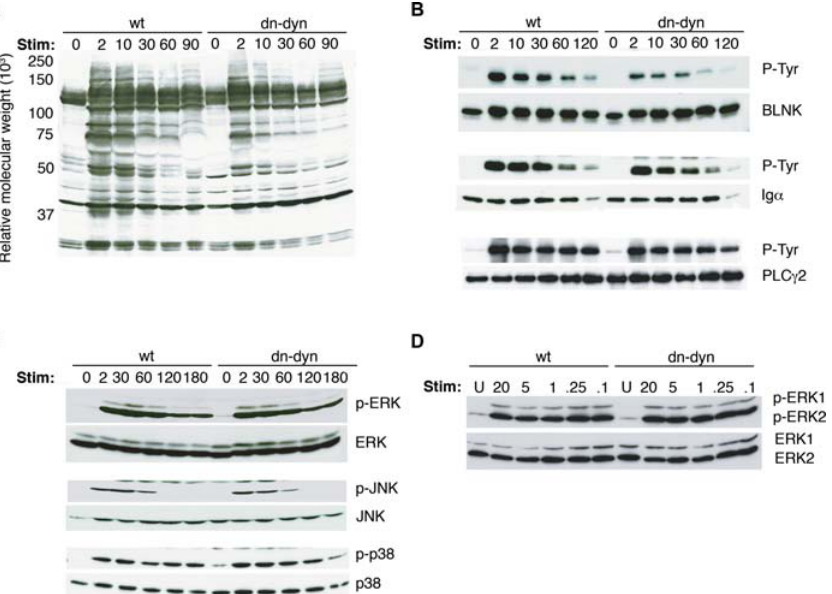
Figure 5. Inhibiting BCR Internalization Has Minimal Effect on Signaling In (A–C), A20IIA1.6 wild-type- or dn-dynamin-expressing cells were stimulated with anti-IgG for the indicated times (min). (A) Total cell lysates were immunoblotted with 4G10. (B) BLNK, Ig a , or PLC c 2 immunoprecipitates were resolved by SDS-PAGE and then immunoblotted as indicated. (C) Total cell lysates were immunoblotted with phospho-specific antibodies to Erk, Jnk, or p38. Membranes were then stripped and reprobed with antibodies against Erk, Jnk, or p38 as indicated. (D) Cells were stimulated with decreasing amounts of anti-IgG (shown in l g/ml) for 3 min. Cells were then assayed for Erk activation as in (C). DOI: